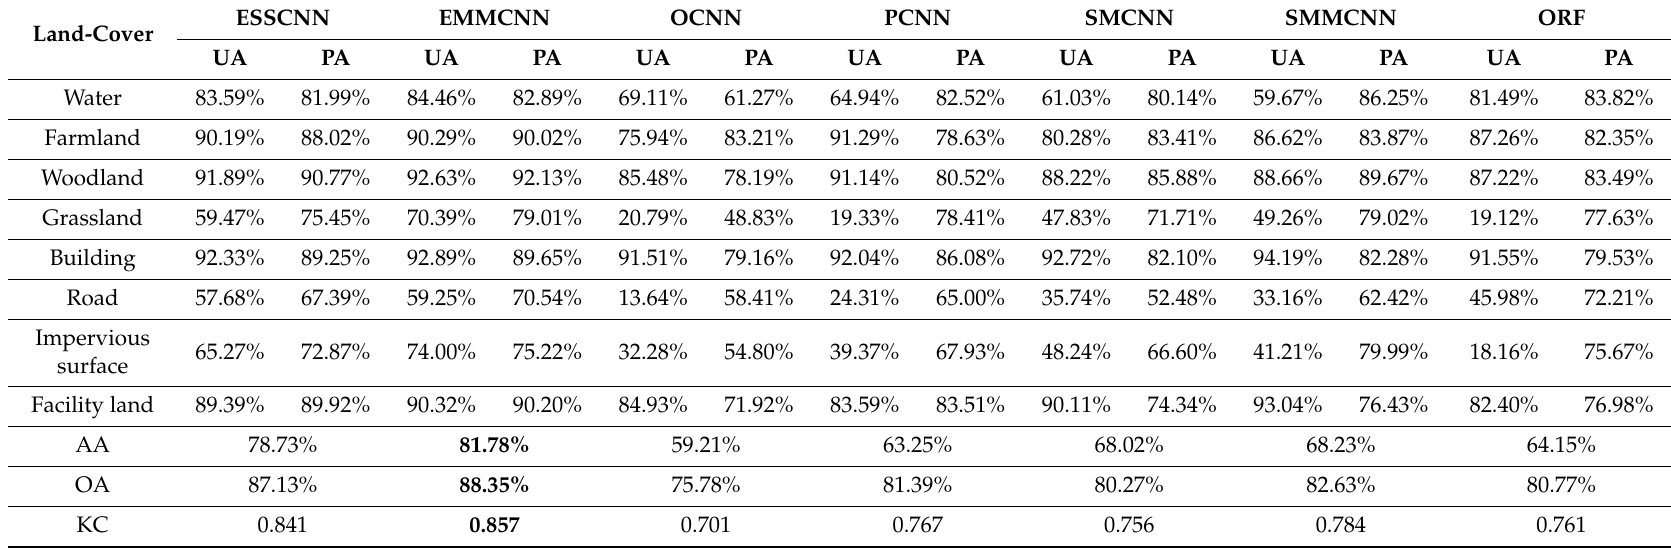
Table 9. Classification accuracy comparison amongst ESSCNN, EMMCNN, OCNN, PCNN, SMCNN, SMMCNN, and ORF methods for the Cixi dataset. Land-Cover